Question: Looking at the figure, what chart type is it?
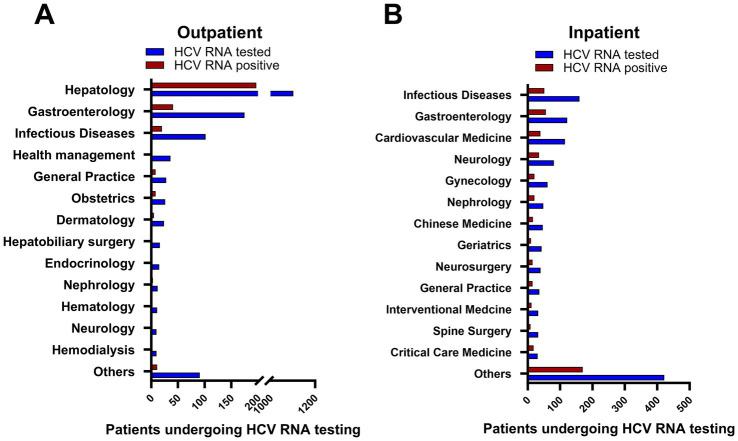
Answer: bar